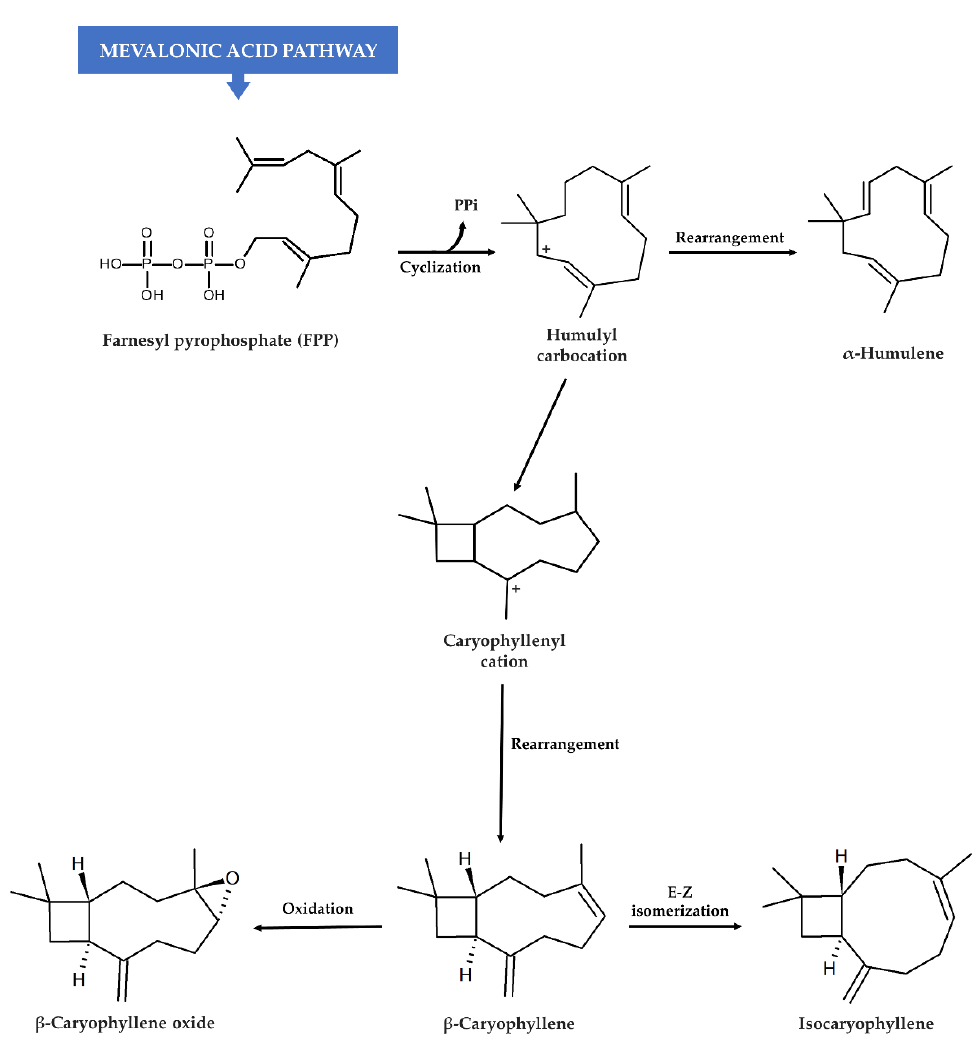
Figure 4. Biosynthetic pathway for β-caryophyllene and its structural analogs in plants [120–122]. Sesquiterpenes are synthesized in nature through the mevalonic acid (MVA) pathway, which supplies the central metabolic C15 intermediate ( E , E )-farnesyl pyrophosphate precursor (FPP); caryophyllane sesquiterpenes are synthetized from FPP as described above.